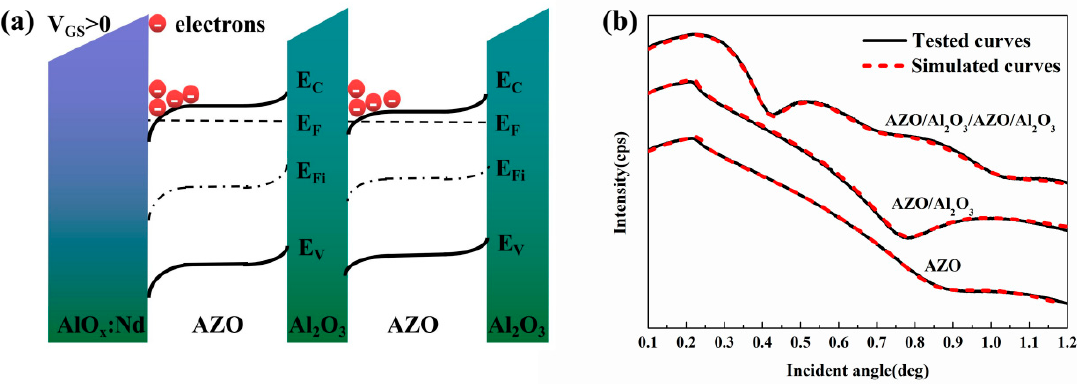
Figure 2. ( a ) Energy band structure and electrical effect of AZO/Al 2 O 3 /AZO/Al 2 O 3 stacked channel layers; ( b ) X-ray reflectivity (XRR) measurements obtained from AZO single layer, AZO/Al 2 O 3 bilayer, and AZO/Al 2 O 3 /AZO/Al 2 O 3 multilayers.